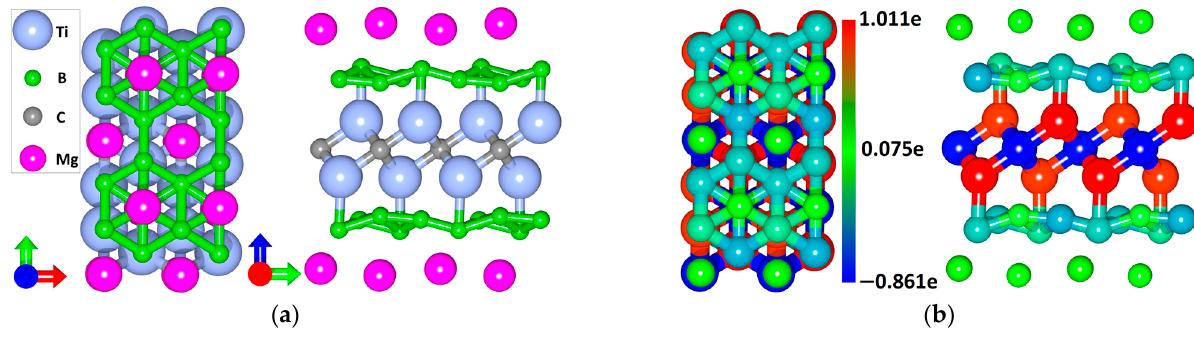
Figure 4. Composite Ti 16 C 8 B 40 in the presence of Mg atoms: ( a ) supercell; ( b ) Mulliken distribution of electronic charge over atoms.